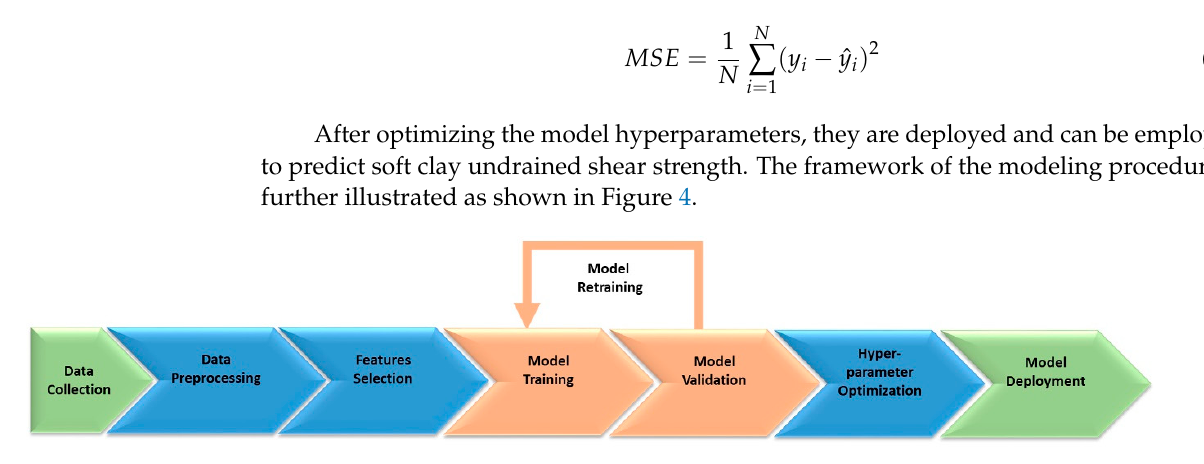
Figure 4. Framework of soft clay ML modeling.